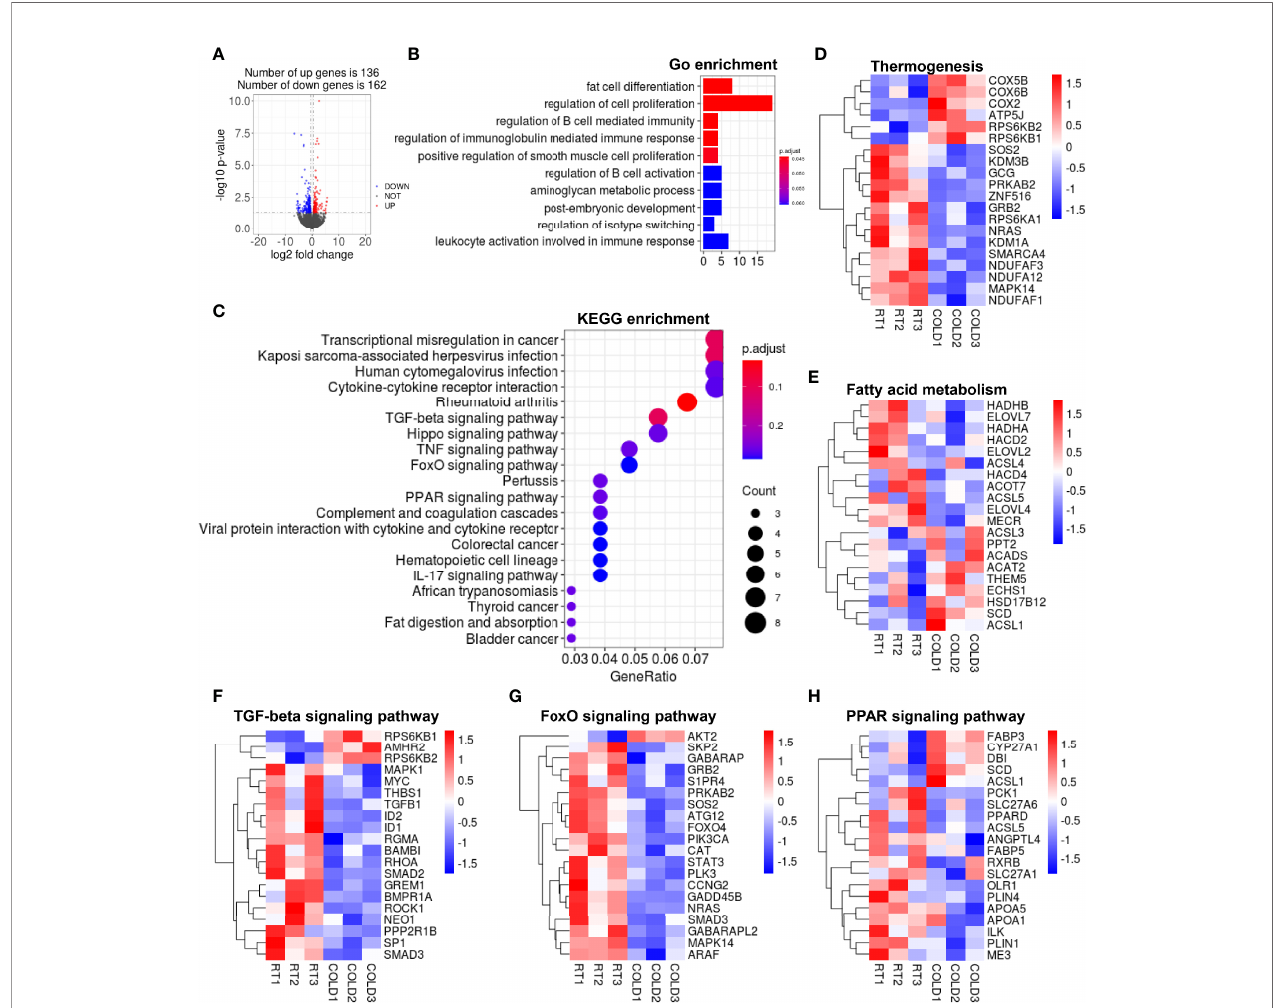
FIGURE 4 | Cold exposure changed the transcriptome pro fi le of VAT in pigs. (A) Volcano plot of differently expressed genes (DEGs) expression patterns were illustrated. Red denotes upregulated genes in COLD VAT; blue denotes downregulated genes in COLD VAT; gray denotes genes with no signi fi cant changes. (B) Gene Ontology (GO) enrichment analysis. (C) Functional enrichment analyses using Kyoto Encyclopedia of Genes and Genomes (KEGG) pathways. (D, E) Heatmaps of the TPM expression values of selected thermogenesis, fatty acid metabolism regulated genes from the RNA-seq dataset. (F – H) KEGG results of the cold-induced enrichment of genes involved in TGF-beta signaling pathway (F) , FoxO signaling pathway (G) , PPAR signaling pathway (H)